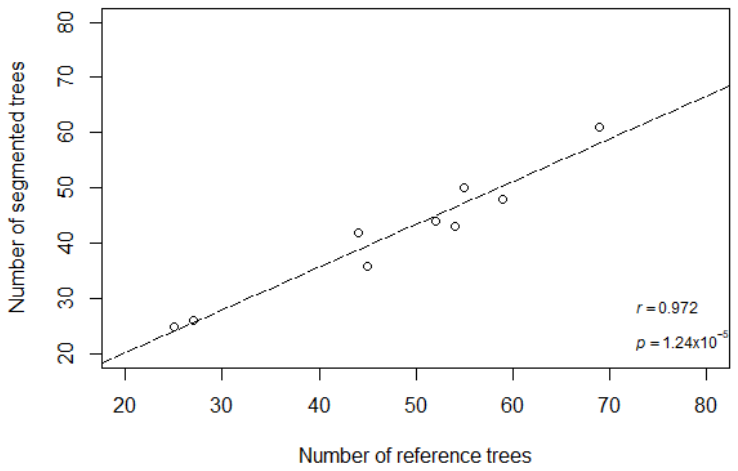
Figure 3. Linear regression model between field tree crown delineated of Pinus sylvestris based on pit-free CHM and region growing segmentation algorithm.